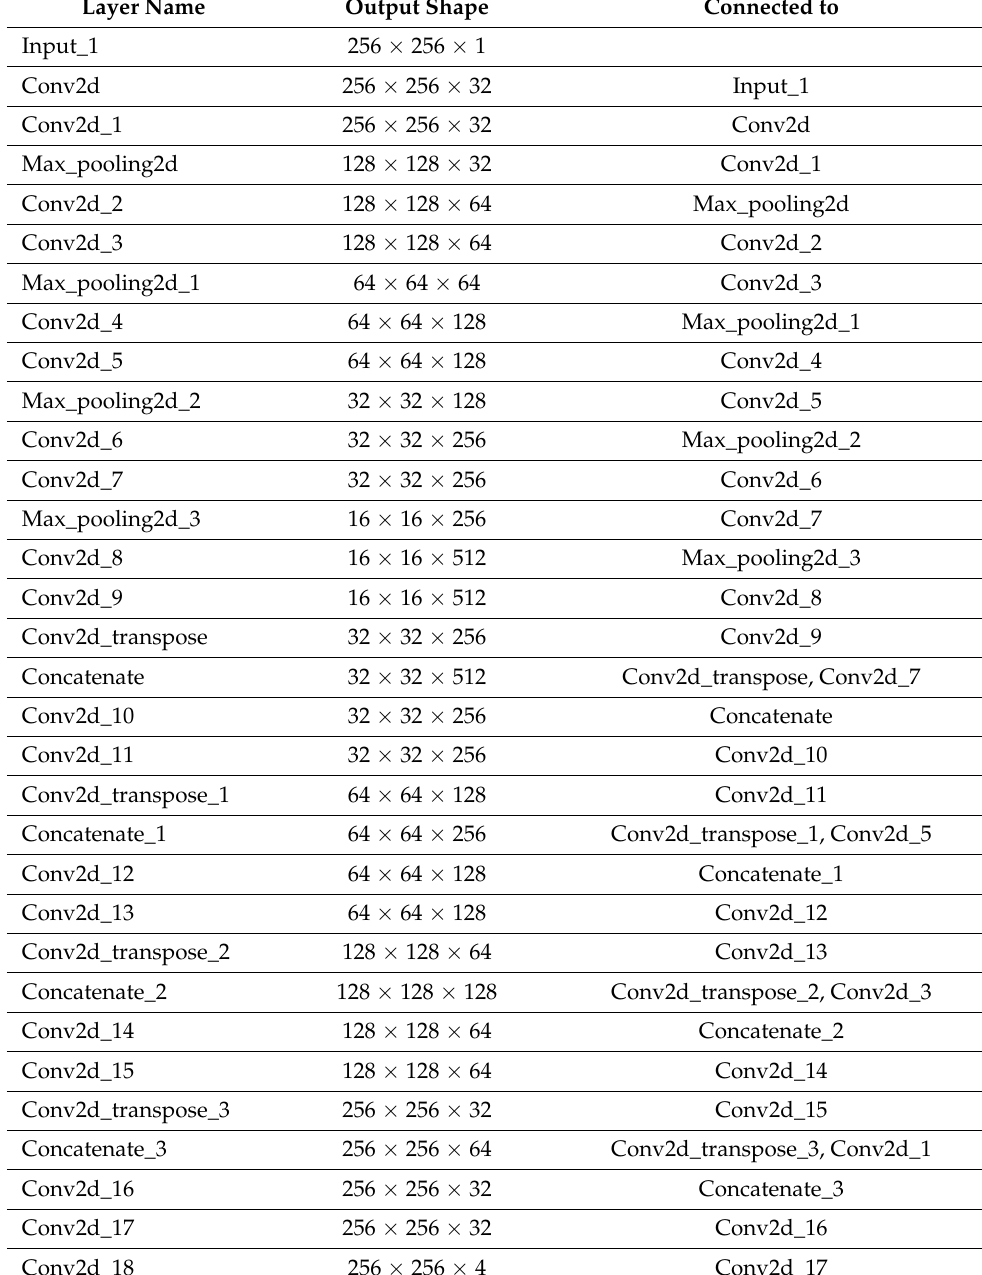
Table 1. Architecture of the single